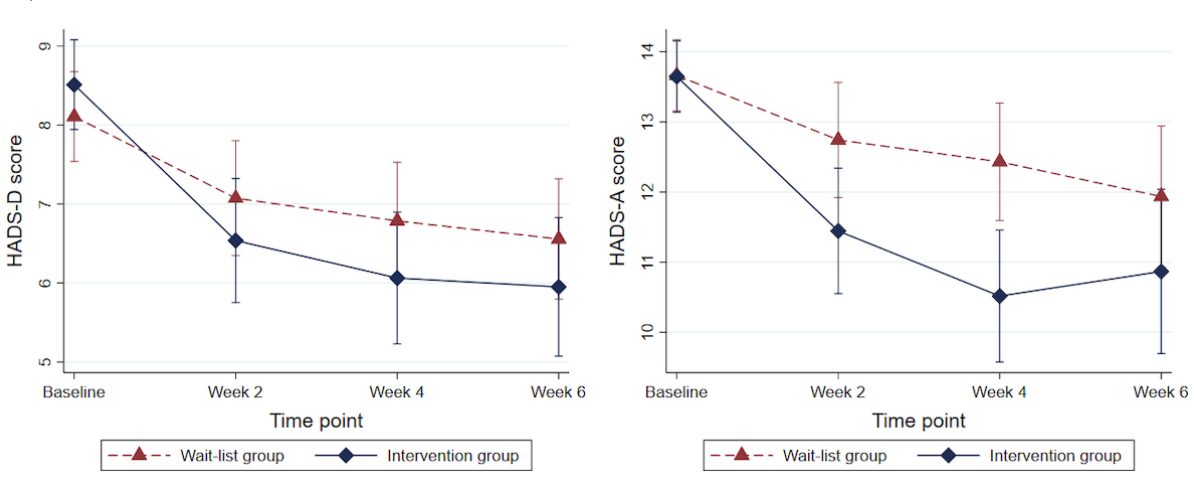
Figure 3. Hospital Anxiety and Depression Scale anxiety and depression scores by study arm, estimated by the adjusted multilevel model at each time point. Error bars represent 95% CIs. HADS-A: Hospital Anxiety and Depression Scale-Anxiety Subscale; HADS-D: Hospital Anxiety and Depression Scale-Depression Subscale.